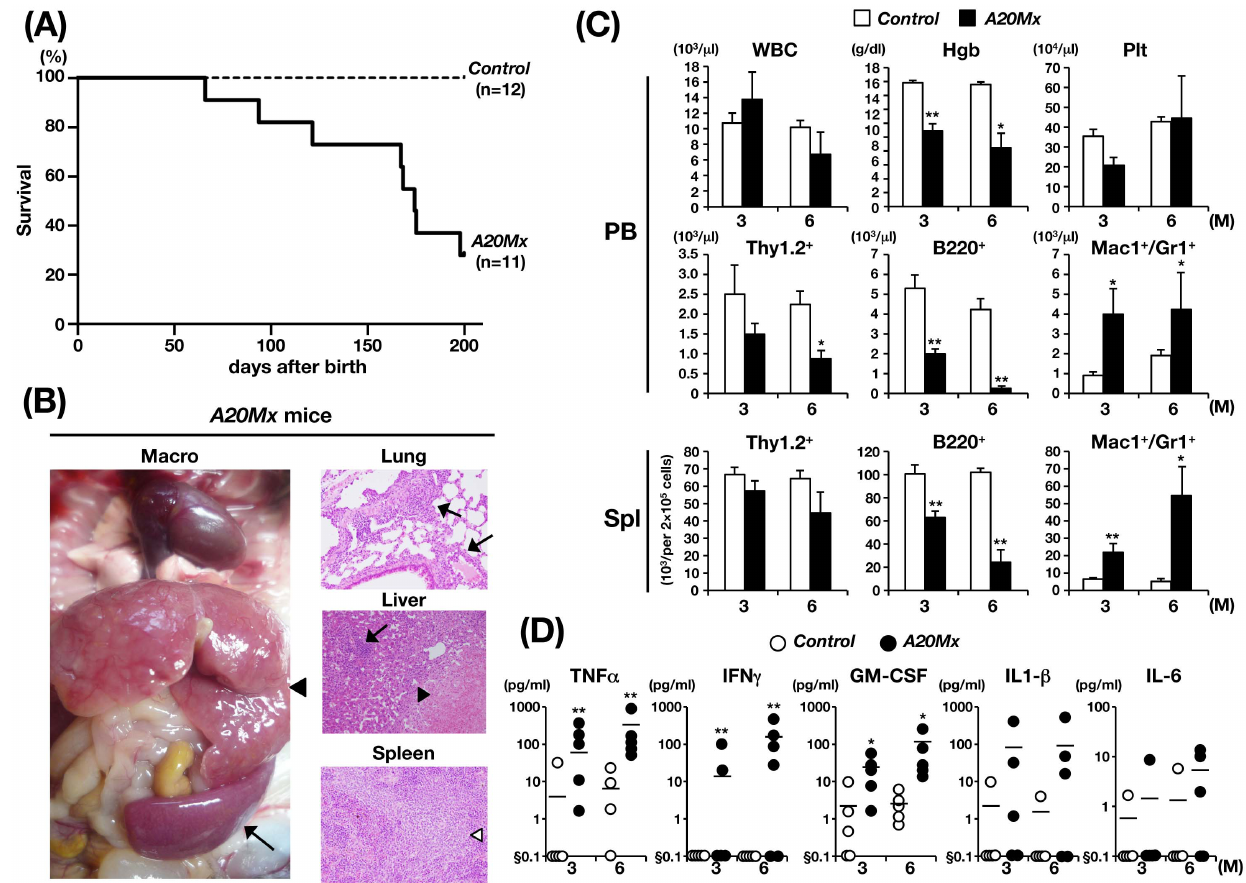
Figure 1. Analysis of A20Mx mice. (A) Kaplan–Meier survival curves. (B) Macroscopic appearance and pathological images of an A20Mx mouse six months after birth. In the left panel, the enlarged liver and spleen are indicated by an arrowhead and an arrow, respectively. In the right panel, infiltrated myeloid cells in the lung and liver, granuloma formation in the liver, and destruction of spleen architecture are indicated by arrows, an arrowhead, and a white arrowhead, respectively. (C) Time-dependent changes in hematopoietic parameters in the PB and spleen. *p , 0.05 and **p , 0.01 (Student’s t -test). (D) Serum concentrations of pro-inflammatory cytokines. *p , 0.05 and **p , 0.01 (Student’s t -test). 1 below standard range and out of invertable